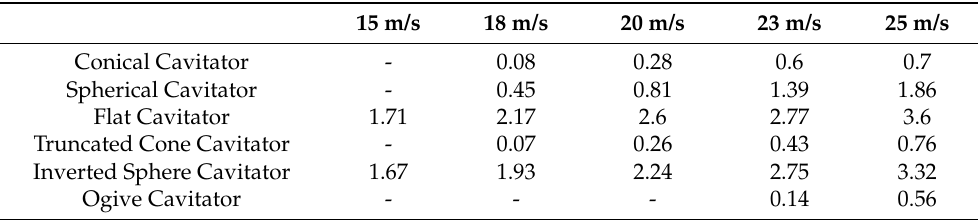
Table 2. The bubble maximal diameter (in multiplies of body diameter) for different cavitators and motion speeds (the sign (-) indicates no bubble existence). 15 m/s 18 m/s 20 m/s 23 m/s 25 m/s Conical Cavitator - 1.05 1.11 Spherical Cavitator - Truncated Cone Cavitator - Inverted Sphere Cavitator 1.67 Ogive Cavitator - -